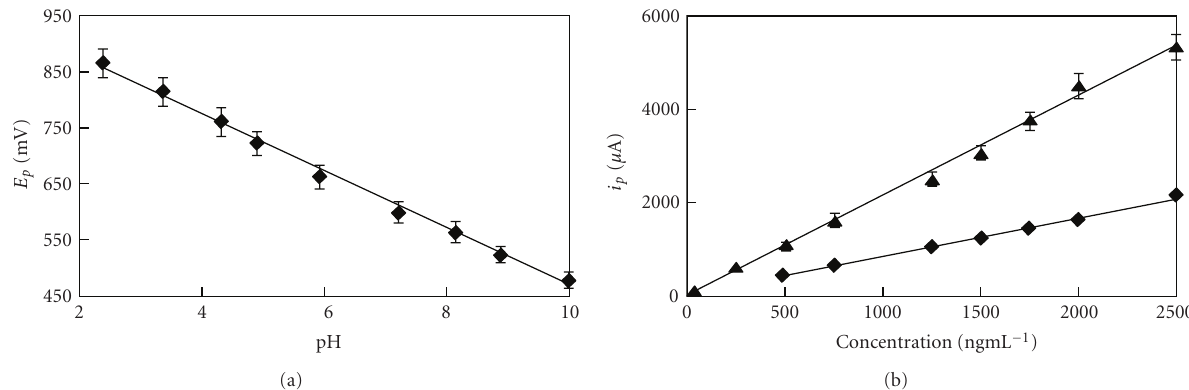
Figure 4: (a) Dependence of pH on peak potential of salbutamol at SWNT/EPPGE. (b) Calibration plot of salbutamol at bare ( (cid:2) ) and SWNT-modified EPPGE ( (cid:3) ) at pH 7.2.